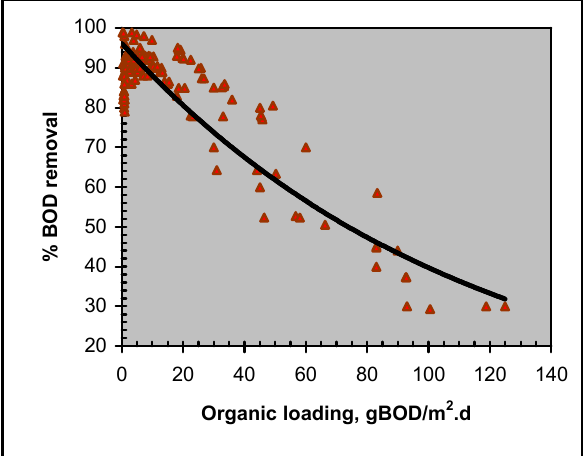
Figure 11: Effect of organic loading on the remaining COD (organic loading up to 400 g COD/m 2 .d).